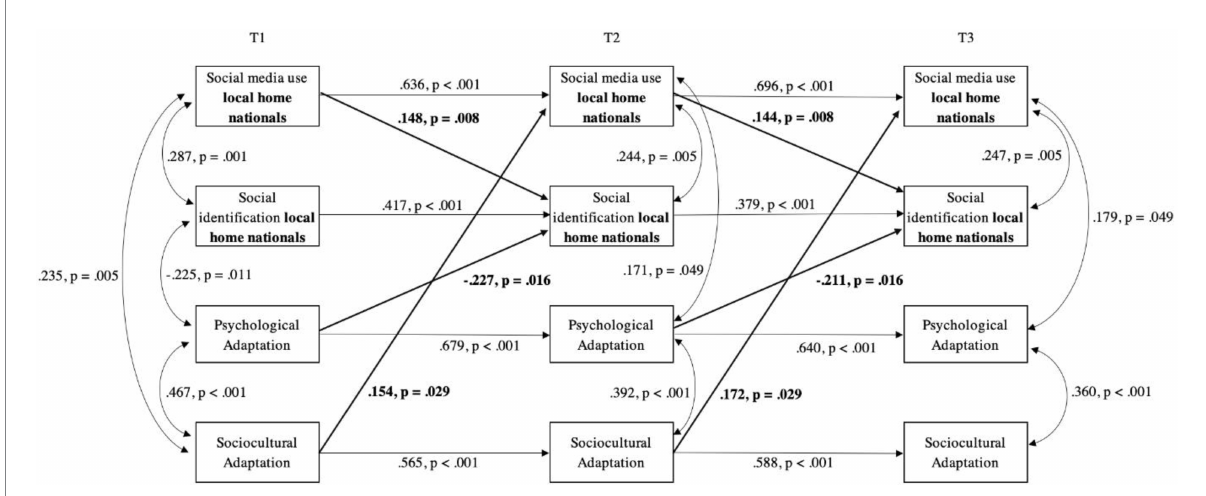
FIGURE 2 Cross-lagged panel model of the relationships between social media use and social identification with local home nationals, and psychological and sociocultural adaptation of international students. Only significant paths are shown. Results have been standardized and constrained to equality between time points. Model Fit: χ 2 (38) = 56.603, p = 0.027, CFI = 0.950; TLI = 0.921; SRMR = 0.072; RMSEA = 0.045, 90% CI [0.016, 0.068], p close = 0.582; N = 233.